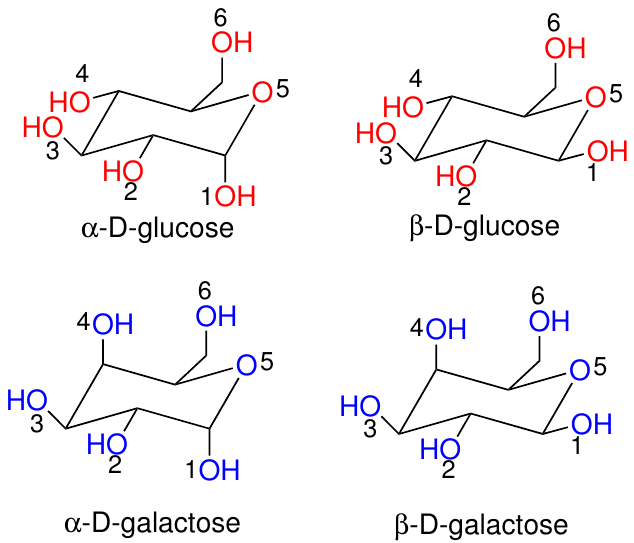
Figure 1. Schematic view of D-gluglucopyranose (alpha and beta) and D-galactopyranose (alpha and